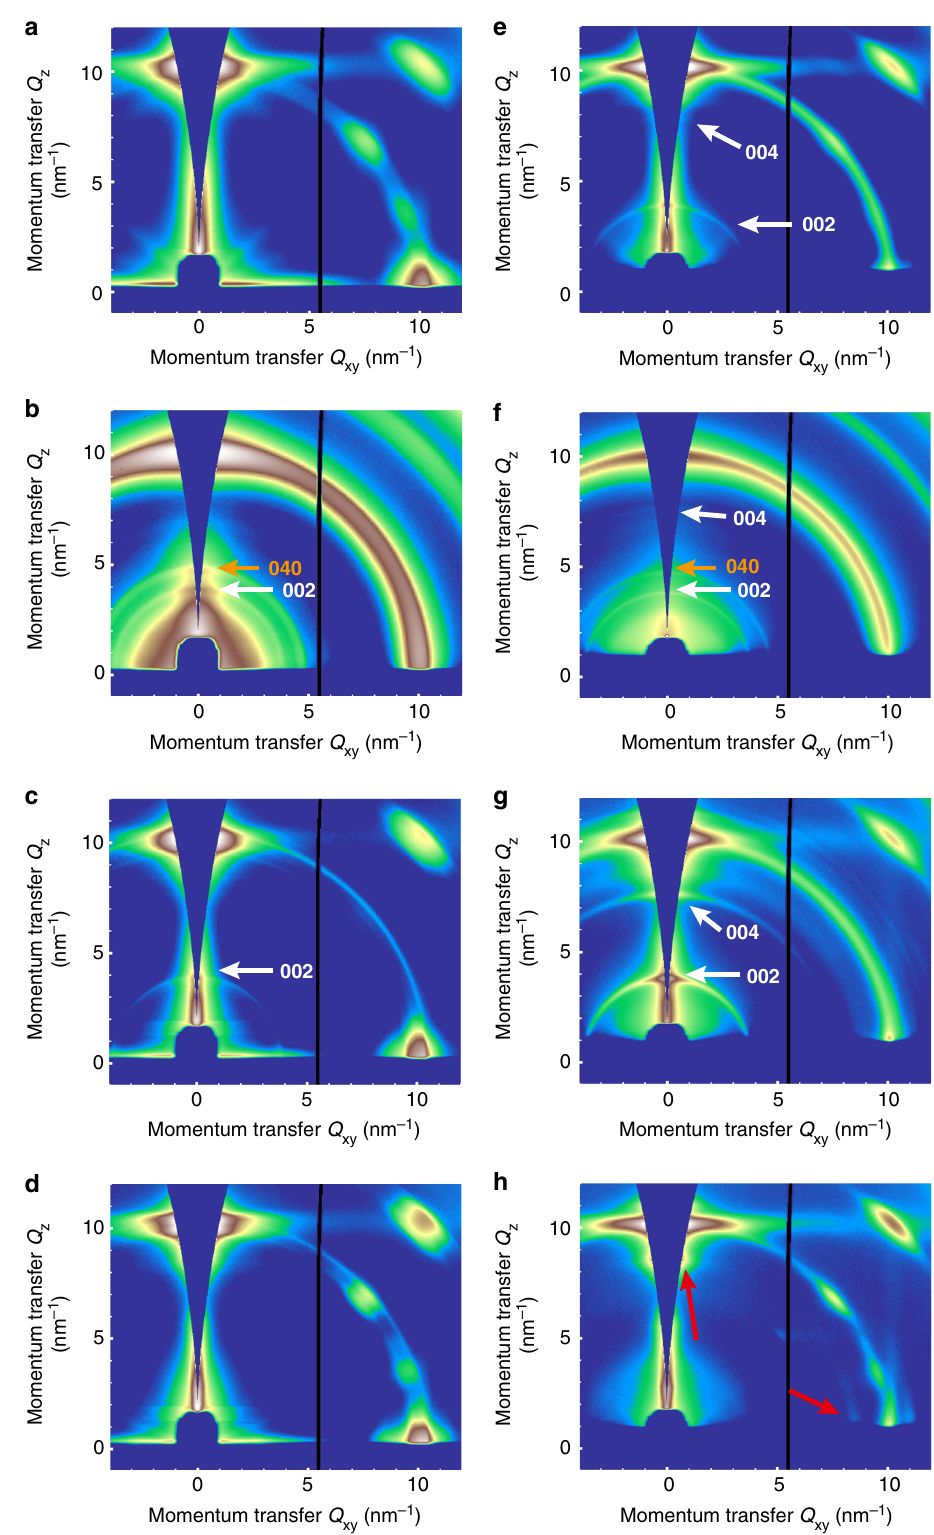
Fig. 4 GIWAXS patterns of 2D OIHP fi lms with PEA and fl uorinated PEAs under different incident angles: GIWAXS patterns of a , e PEA, b , f oF1PEA, c , g mF1PEA, and d , h pF1PEA 2D OIHP fi lms probing at two different X-ray incident angles; left column ( a – d ) shows patterns acquired at incident angle = 0.18°, probing a few nanometers of the perovskite fi lms from the front (air) interface respectively, while right column ( e – h ) shows patterns acquired at incident angle = 1°, probing more into the bulk of the fi lms. Arrows and their indices indicate distinct peaks from 2D phases: white and orange arrows show n = 1, and n = 3, and red arrows indicate peaks which are possibly due to the larger n values such as n = 4. Peaks were indexed by comparing the GIWAXS experimental patterns to a set of simulated diffraction patterns using CrystalDiffract ® (Version